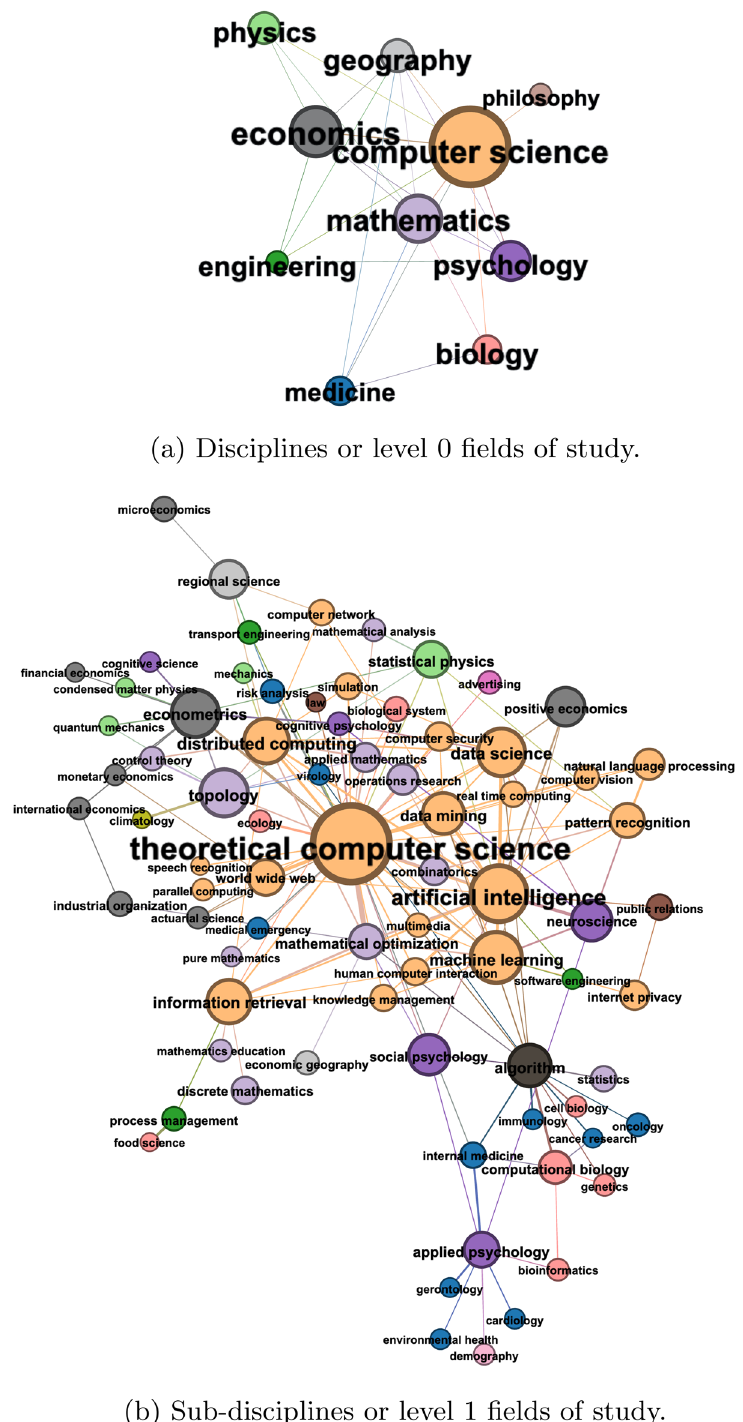
Fig. 3 FoS Network for research published in related to the journal “Applied Network Science” during 2016–2019. Node size encodes the number of papers attributed to a field of study. In ( b ) nodes are coloured to represent the parent discipline of the field of study. Edges are coloured to show the parent discipline if the edge is within a discipline/community. Edges between communities are not